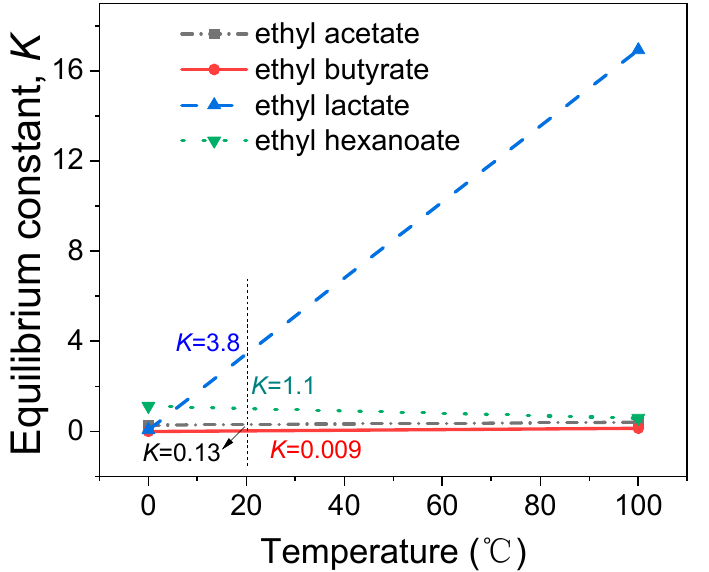
Figure 3. Correlation between the K of the esterification process of Baijiu esters and temperature in the range of 0 °C–100 °C.